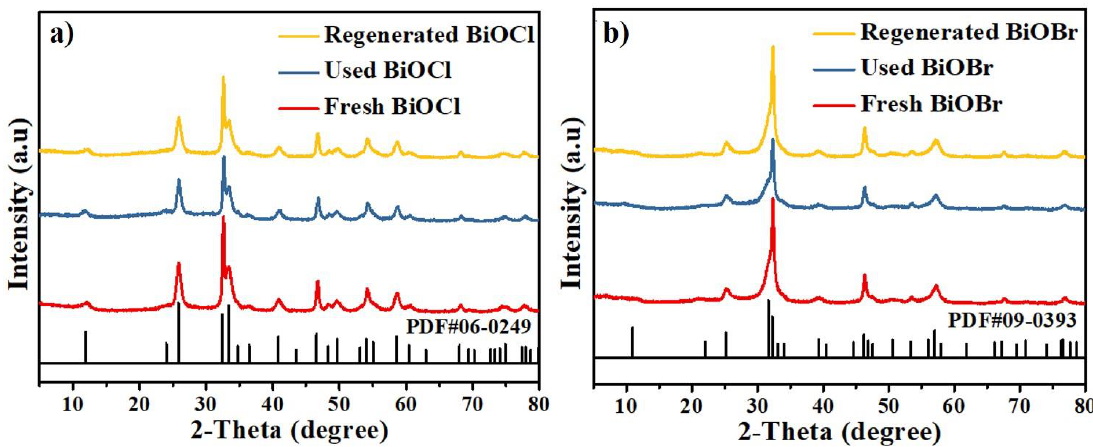
Figure 5. XRD images of BiOCl ( a ) and BiOBr ( b ).